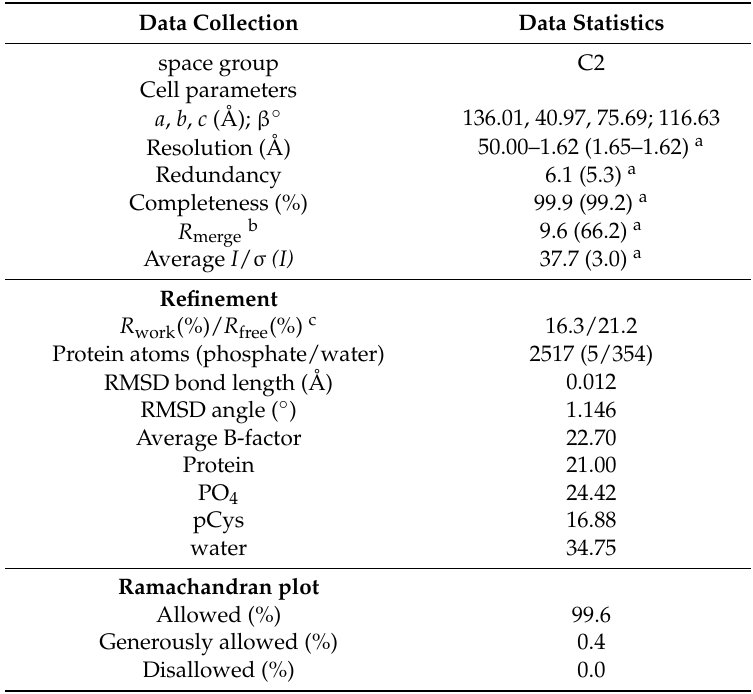
Table 1. Data collection and structure refinement